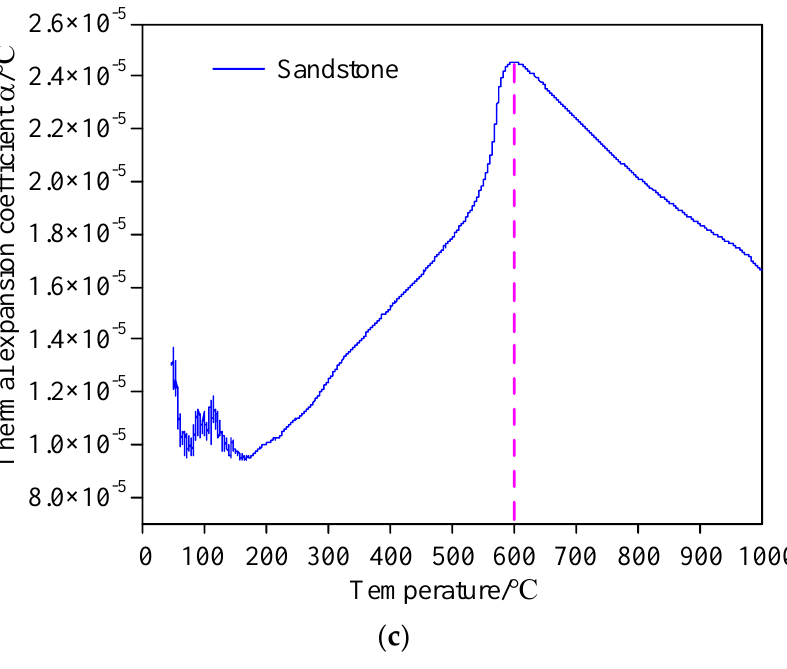
Figure 3. Thermophysical properties of sandstone samples before and after heating. ( a ) Variation curve of specific heat capacity of sandstone samples with temperature; ( b ) Variation curve of thermal conductivity of sandstone samples with temperature; ( c ) Variation curve of thermal expansion coefficient of sandstone samples with temperature.